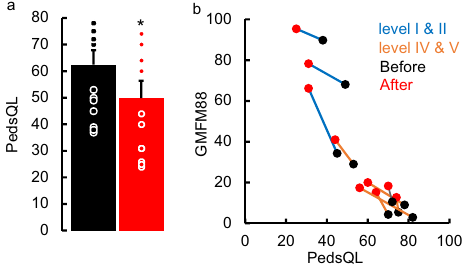
Fig. 3 | Quality of Life Changes. a mean±SE (n=12, GMFCS levels I and II, n=3, GMFCSlevelsIVandV,n=9)PedsQLscoresbeforeandaftertherapy.Alldatawere tested for normality using the Kolmogorov-Smirnov test. Based on the result of a normal distribution, paired t-tests were used to compare the group mean data before and after therapy. * Signi fi cantly different from before therapy at P < 0.05 . Note the max score on the PedsQL is 88 points and a decrease in score represents animprovementinfunction. b X-YplotforcorrelatingGMFM-88scoresatstartand end of therapy with the PedsQL scores demonstrating that the increase in GMFM- 88 scores (improved sensorimotor function of the child) is directly linked to the decreaseinPedsQLscores(improvedqualityoflifeofparent).Pleasenote,datafor n =12 out of 16 are shown since 4 PedsQL data points were not collected. Source data are provided as a Source Data fi le.